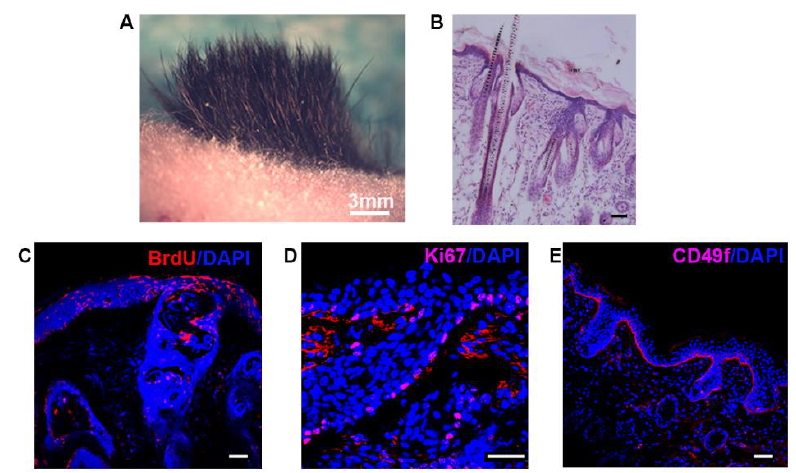
Figure 8. SKPs induced human Epi-SCs to form hair follicles in a C-GAG matrix. The C-GAG matrix was seeded with a mixture of culture-expanded SKPs and adult human Epi-SCs (derived from foreskin), and was implanted into excisional wounds in nude mice. ( A ) Three weeks later, hairs generated at the wound site. Scale bar: 3 mm. ( B ) Histological analysis of the wound site showed hair follicles and sebaceous glands in the dermis. ( C ) When the human Epi-SCs were pre-labeled with BrdU before transplantation, fluorescence analysis using an antibody against BrdU revealed the presence of human cells in the newly-formed epidermis and hair follicles. ( D ) The Ki67 + stain indicated that many cells in the neogenic hair follicles and epidermis were dividing. ( E ) Staining with an antibody against CD49f detected positive cells in the basal layer epidermis, suggesting the formation of a long-term renewable structure by human Epi-SCs. Scale bars: 50 μm.